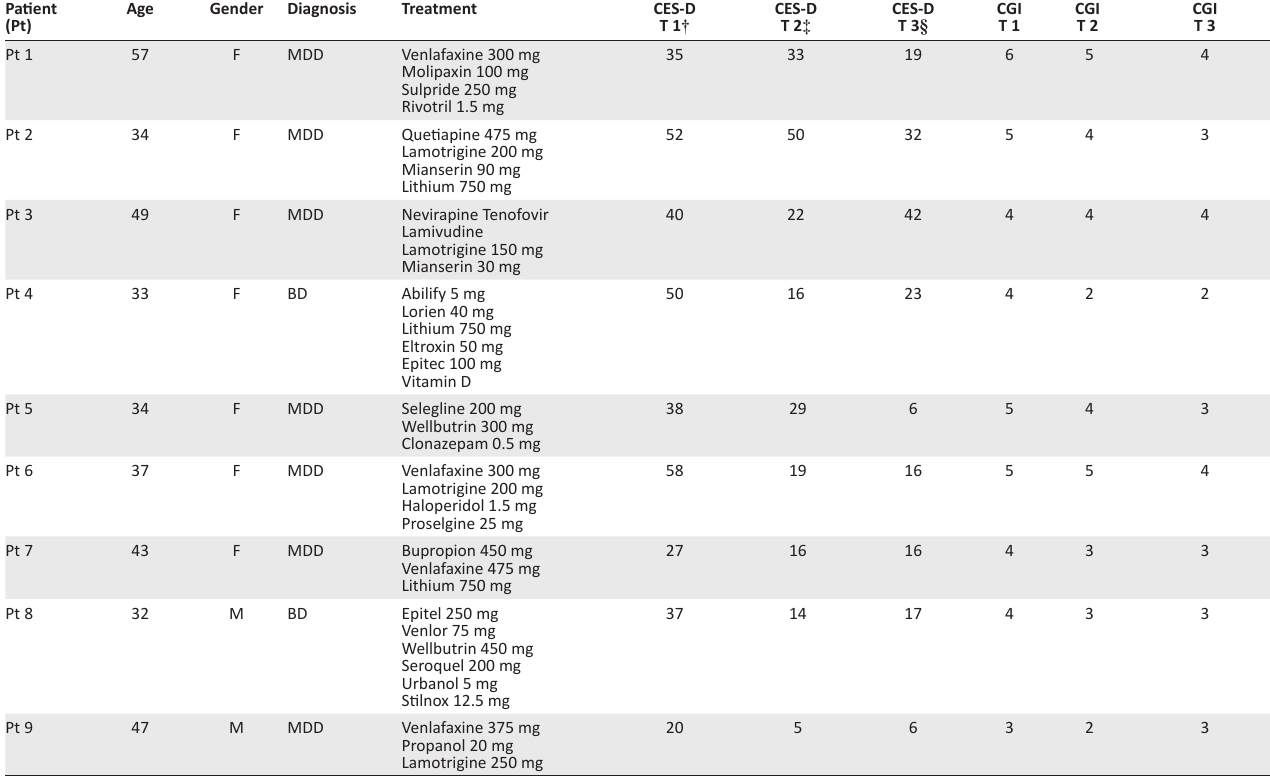
TABLE 1: Subjects and clinical